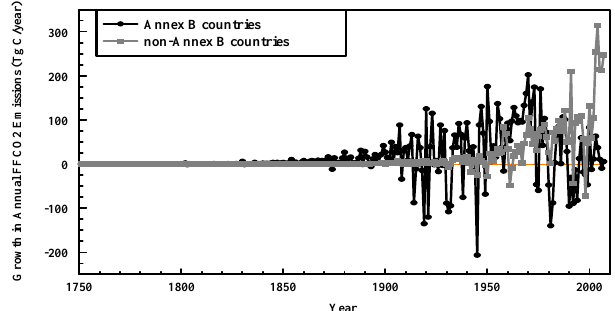
Fig. 3e. Annual FFCO2 emissions for the years 1751 to 2007, disaggregated by Kyoto Protocol status. Similar to Figure 3a. This figure was created from the sum of national consumption values (see section 1) for 15,830 country-year pairs. For Yugoslavia and the USSR, two countries whose dissolution resulted in some states which signed the Kyoto Protocol and some states which did not sign, pre-dissolution emissions have been proportioned to the first year after dissolution. A dashed vertical line marks the Kyoto protocol base year of 1990. Data from Boden et al. (2010).